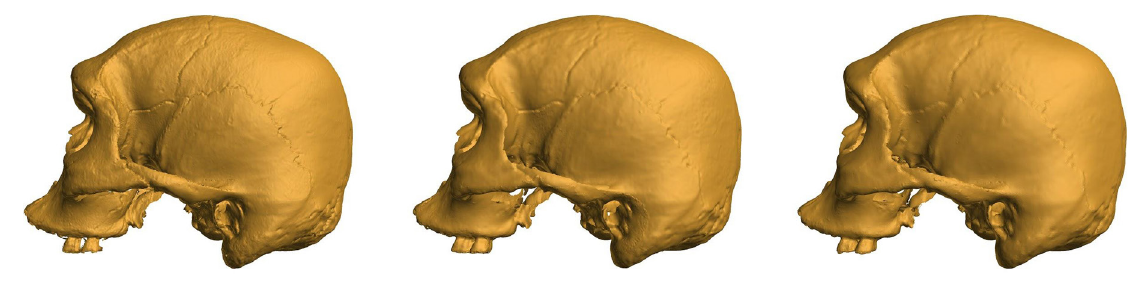
Fig. 3.30. Human skull digitised with NextEngine. On the left in macro mode, in the middle in standard mode and on the right with wide